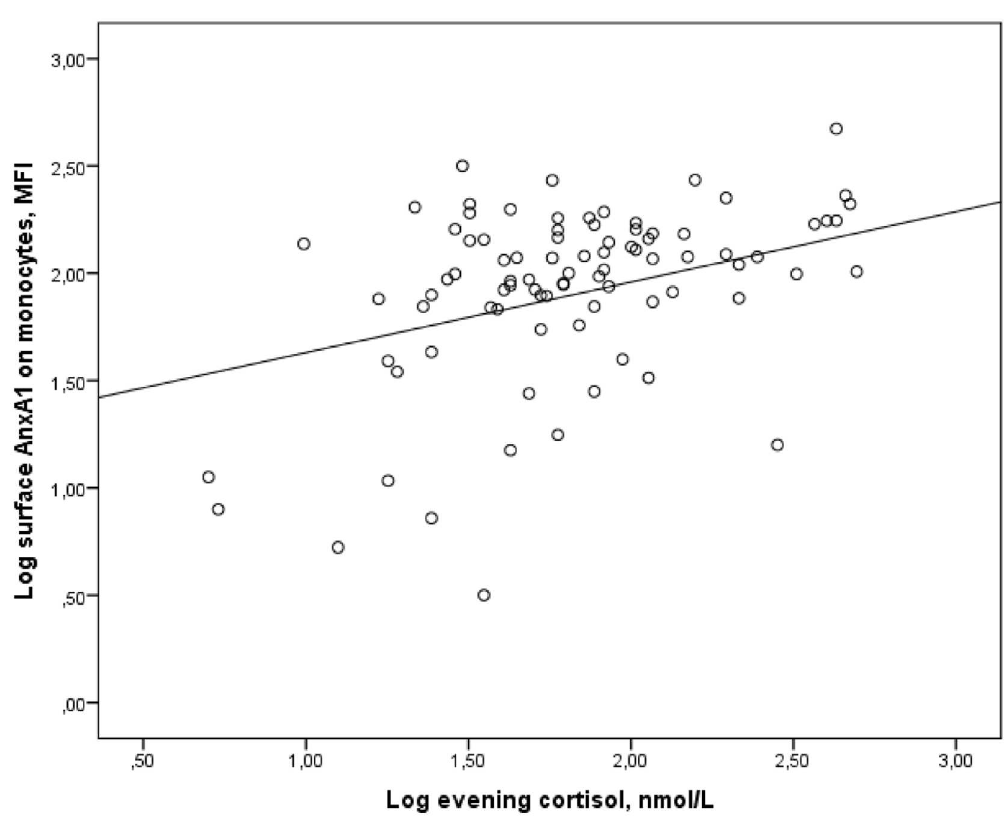
Fig 4. Correlation between surfaceAnxA1 expression on monocytes and evening cortisol levels. The figure shows the correlationbetweenlog transformed values of MFI values of surface AnxA1 expressionon monocytesin peripheral blood and salivary eveningcortisol, r = 0.298, p =